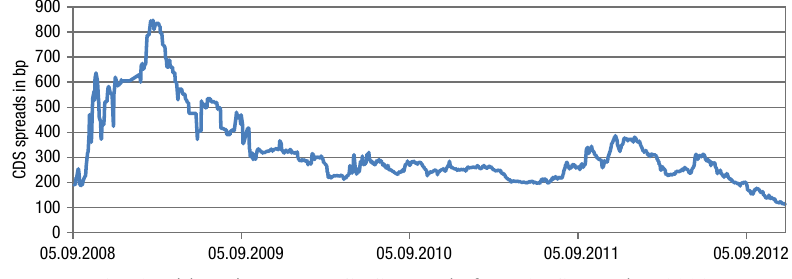
Fig. 1. Lithuanian 5-year CDS spreads from 15 September 2008 to 1 March 2013 in basis